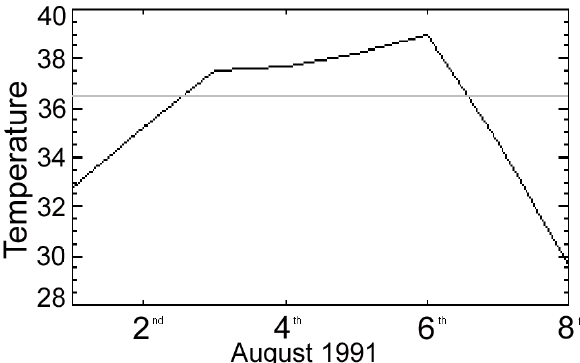
Fig. 6. Evolution of maximum daily temperature during the stagna- tion period that occurred between 3 and 6 August